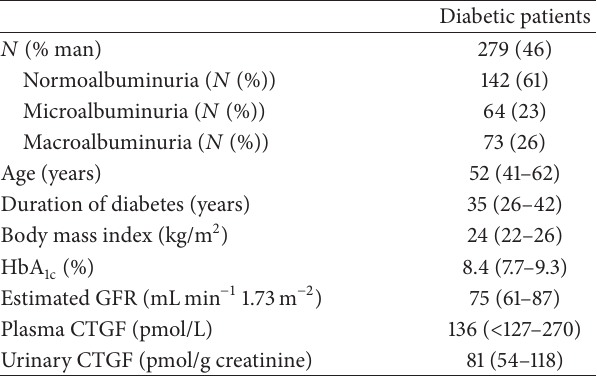
Table 2: General and clinicalcharacteristics of the diabetic